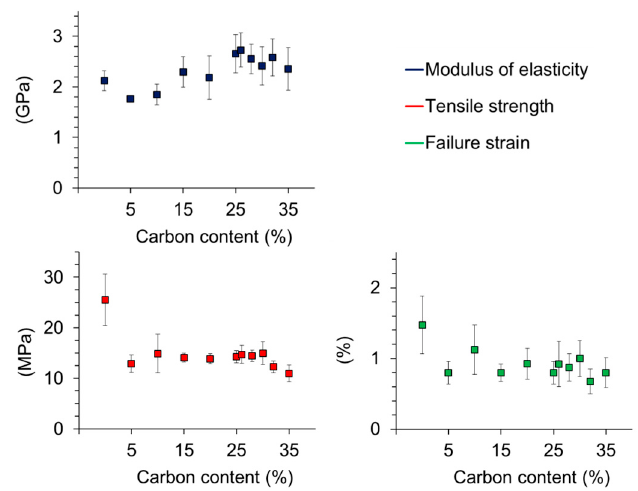
Figure 10. Relationship between mechanical properties and lignin-based carbon microparticle loading of poly(lactic acid) composites.